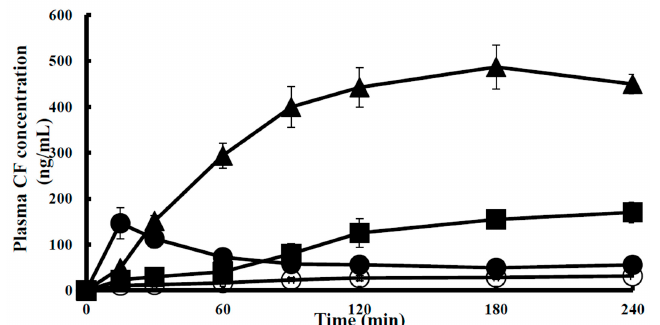
Figure 2. The profile of concentration vs. time course of 5(6)-carboxyfluorescein (CF) in the plasma after an enteric administration with SLG-30, a gemini surfactant, or typical absorption enhancers including sodium glycocholate and sodium laurate by an in situ closed-loop method. The results are expressed as the mean ± S.E. ( n = 3). Keys: